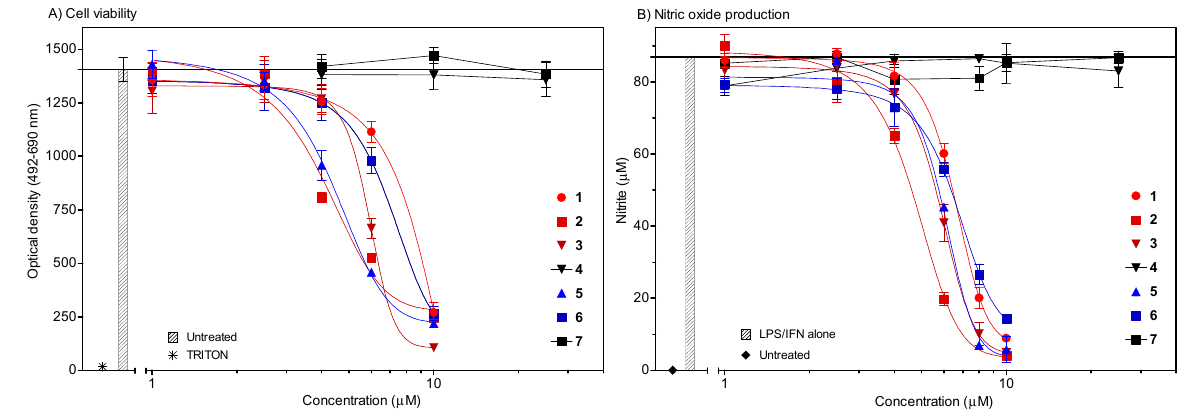
Figure 3. Cytotoxicity ( A ) and NO inhibitory effects ( B ) of Compounds 1 – 7 in mouse peritoneal cells. ( A ) Compounds were applied at appropriate concentrations and cells were cultured for 24 h. LDH assay was used for viability evaluation. The results are expressed in optical density of untreated control or treated cells ± SEM of n = 8 values from two independent experiments. ( B ) The cells were treated with compounds for 24 h with or without LPS (lipopolysaccharide) and IFN- γ (interferon-gamma). The results represent the mean ± SEM of two independent experiments, n = 6.